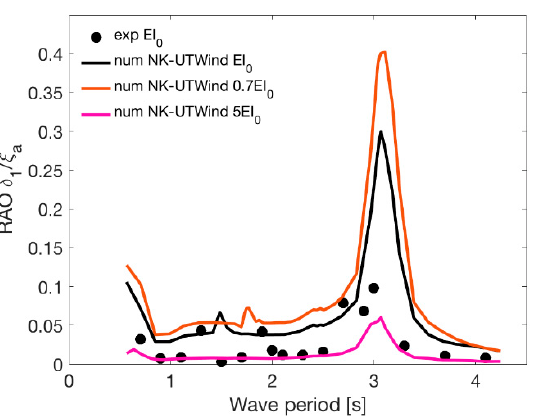
Figure 15. RAO punctual displacement due to the elastic deformation at the tower top result comparisons between the experiment and NK-UTWind numerical calculation for different structural rigidities.